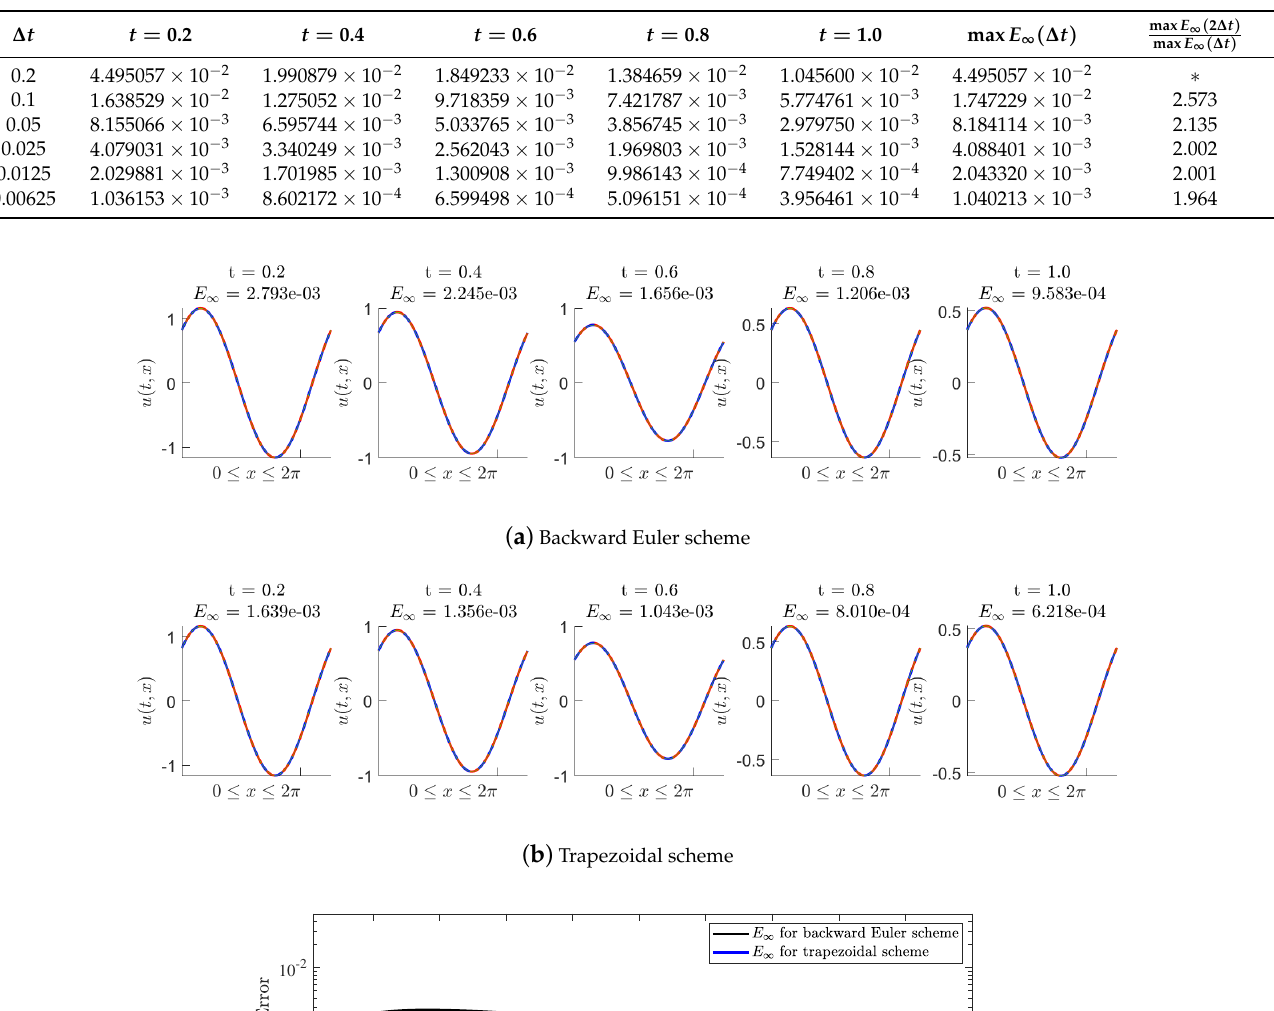
Table 6. Problem of Example 4: maximum absolute error E ∞ at five time nodes for different ∆ t under the trapezoidal scheme and the convergence order in time.